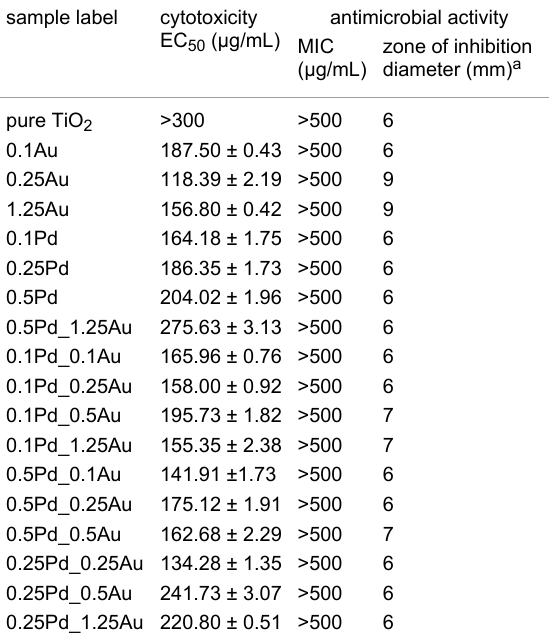
Table 1: Cytotoxicity and antimicrobial activity (MIC and microorgan- ism growth inhibition zone) of TiO 2 modified with Pd and/or Au nano- particles. Figure 1: The effect of the amount and type of metal precursor on the structure of the nanoparticles.